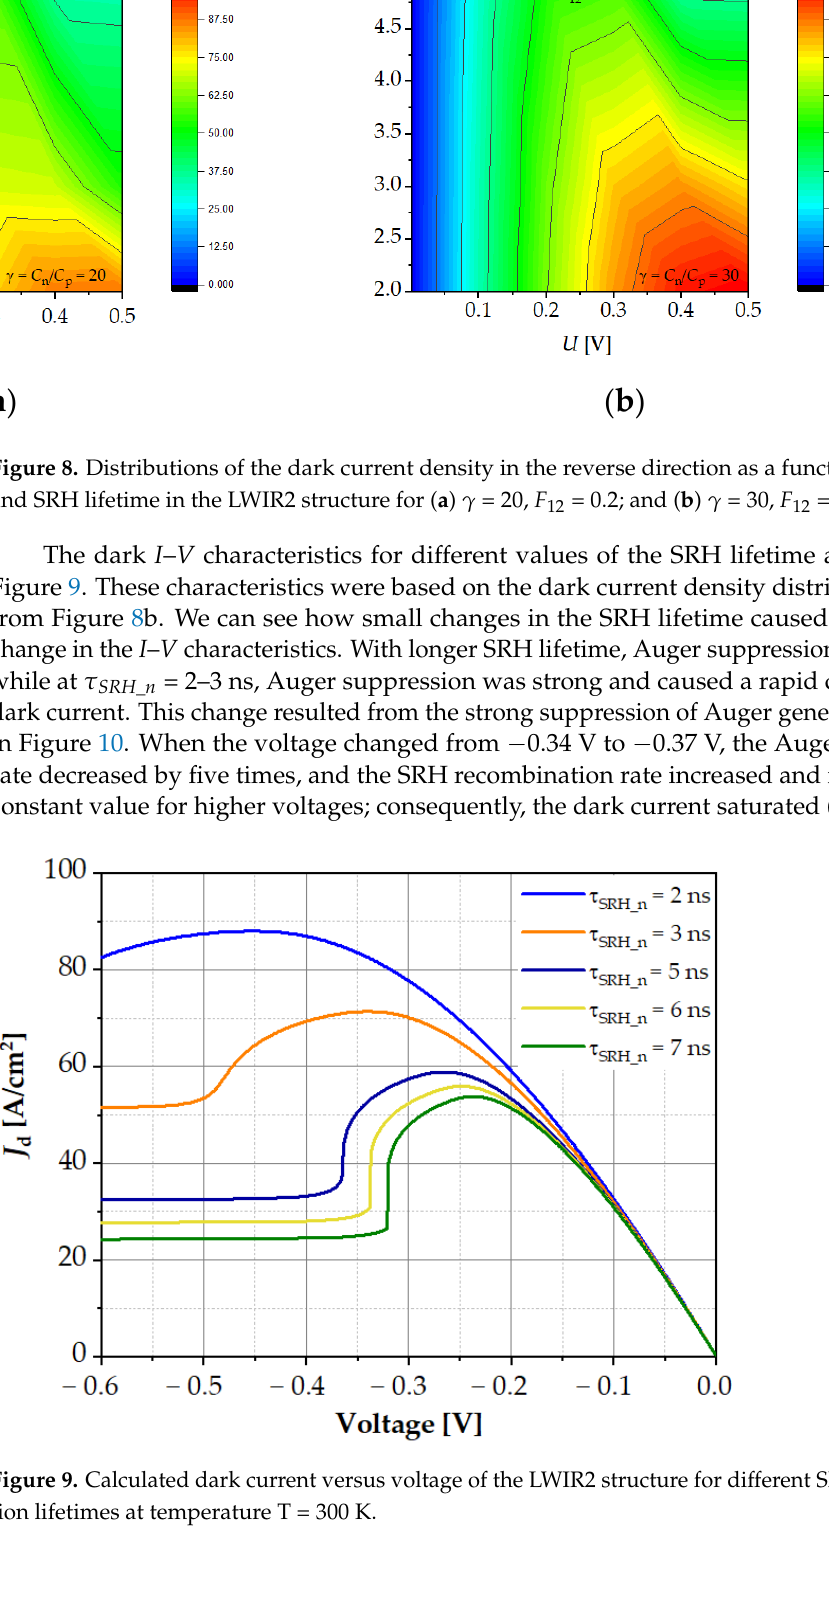
Figure 9. Calculated dark current versus voltage of the LWIR2 structure for different SRH recom- bination lifetimes at temperature T = 300 K.